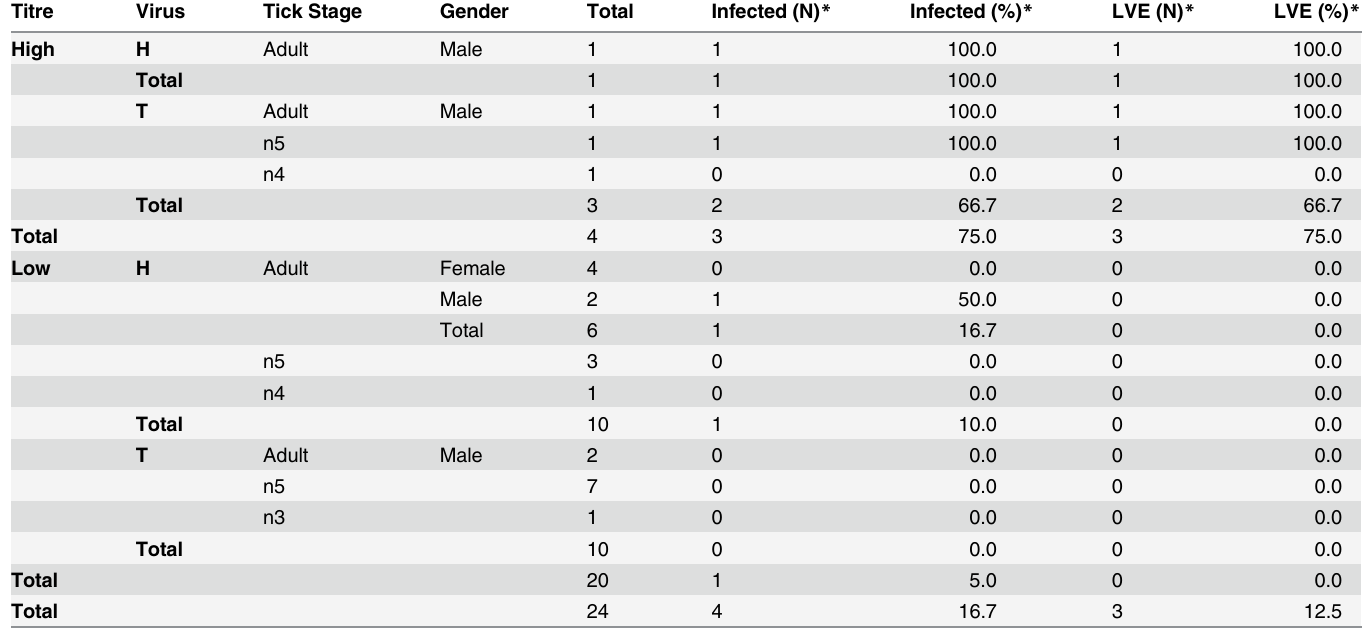
Table 5. Proportion of ticks inoculated with high and low titres of viruses H and T that became infected and with likelihood of virus excretion